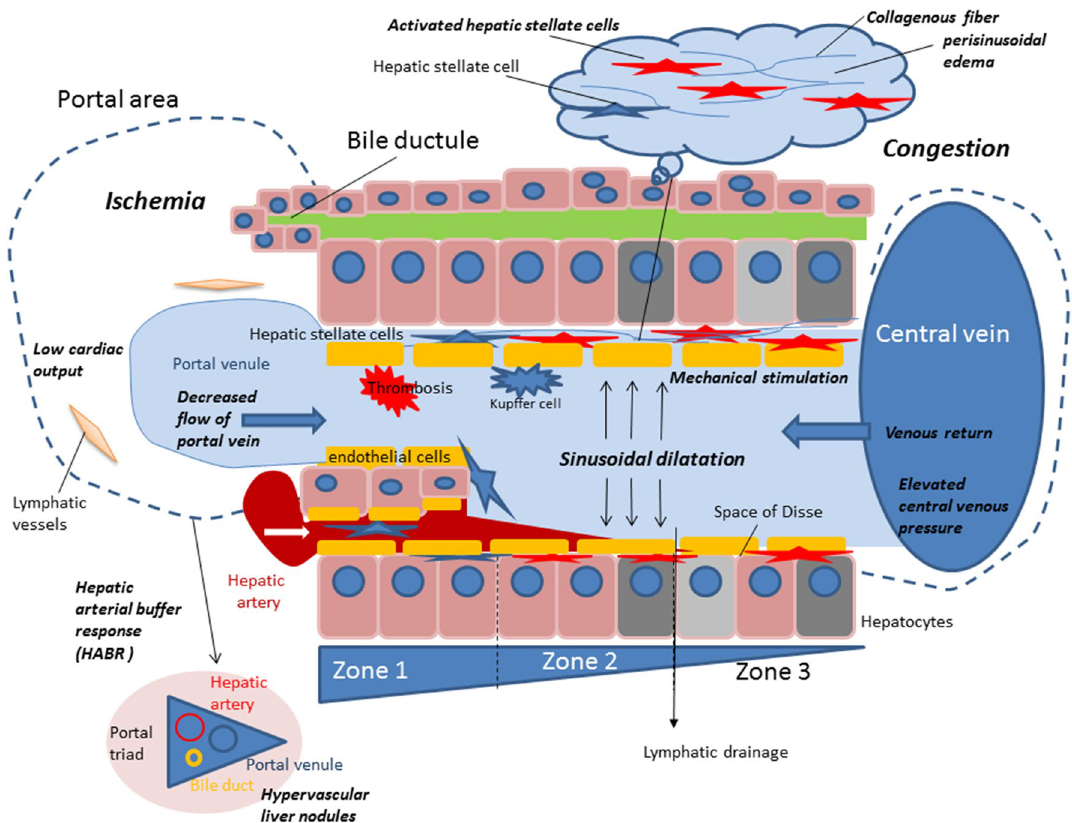
Figure 2. Fontan physiology. Increased venous pressures and decreased cardiac output and hepatic venous drainage result in sinusoidal dilatation around the central veins. This causes congestion and hypoxia in the liver, leading to Fontan-associated liver disease (FALD). Hepatic stellate cells are activated and collagenous fibers are produced. Decreased portal flow induces a hepatic arterial buffer response (HABR) and hypervascular nodules are formed mainly in peripheral areas of the